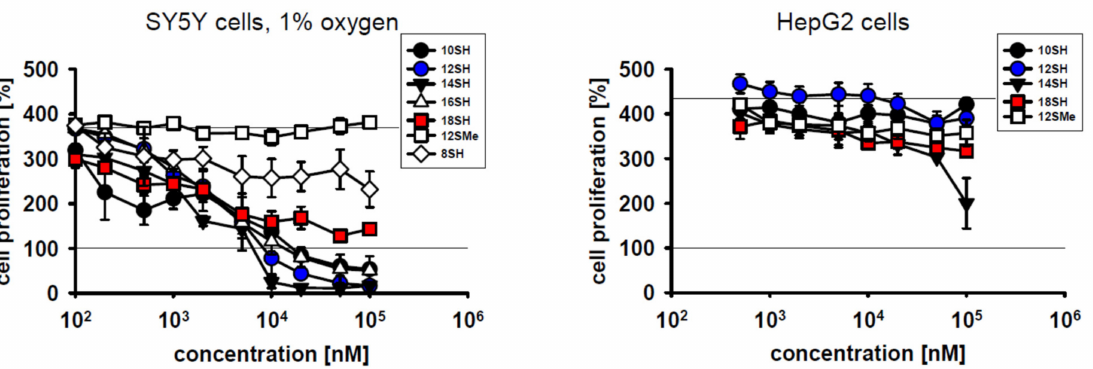
Figure 3. Cytotoxicity of chain-transfer agents in SY5Y cells under hypoxic culture conditions and in HepG2 cells. Compound-treated SY5Y cells were cultivated at 1% oxygen partial pressure under otherwise unchanged conditions for 3 days. Hypoxic culture conditions only modestly lowered baseline proliferation of the SY5Y cells from ~500% to ~400% as per MTT assay. HepG2 hepatocellular carcinoma cells were cultivated at 20% oxygen partial pressure and evaluated as in Figure